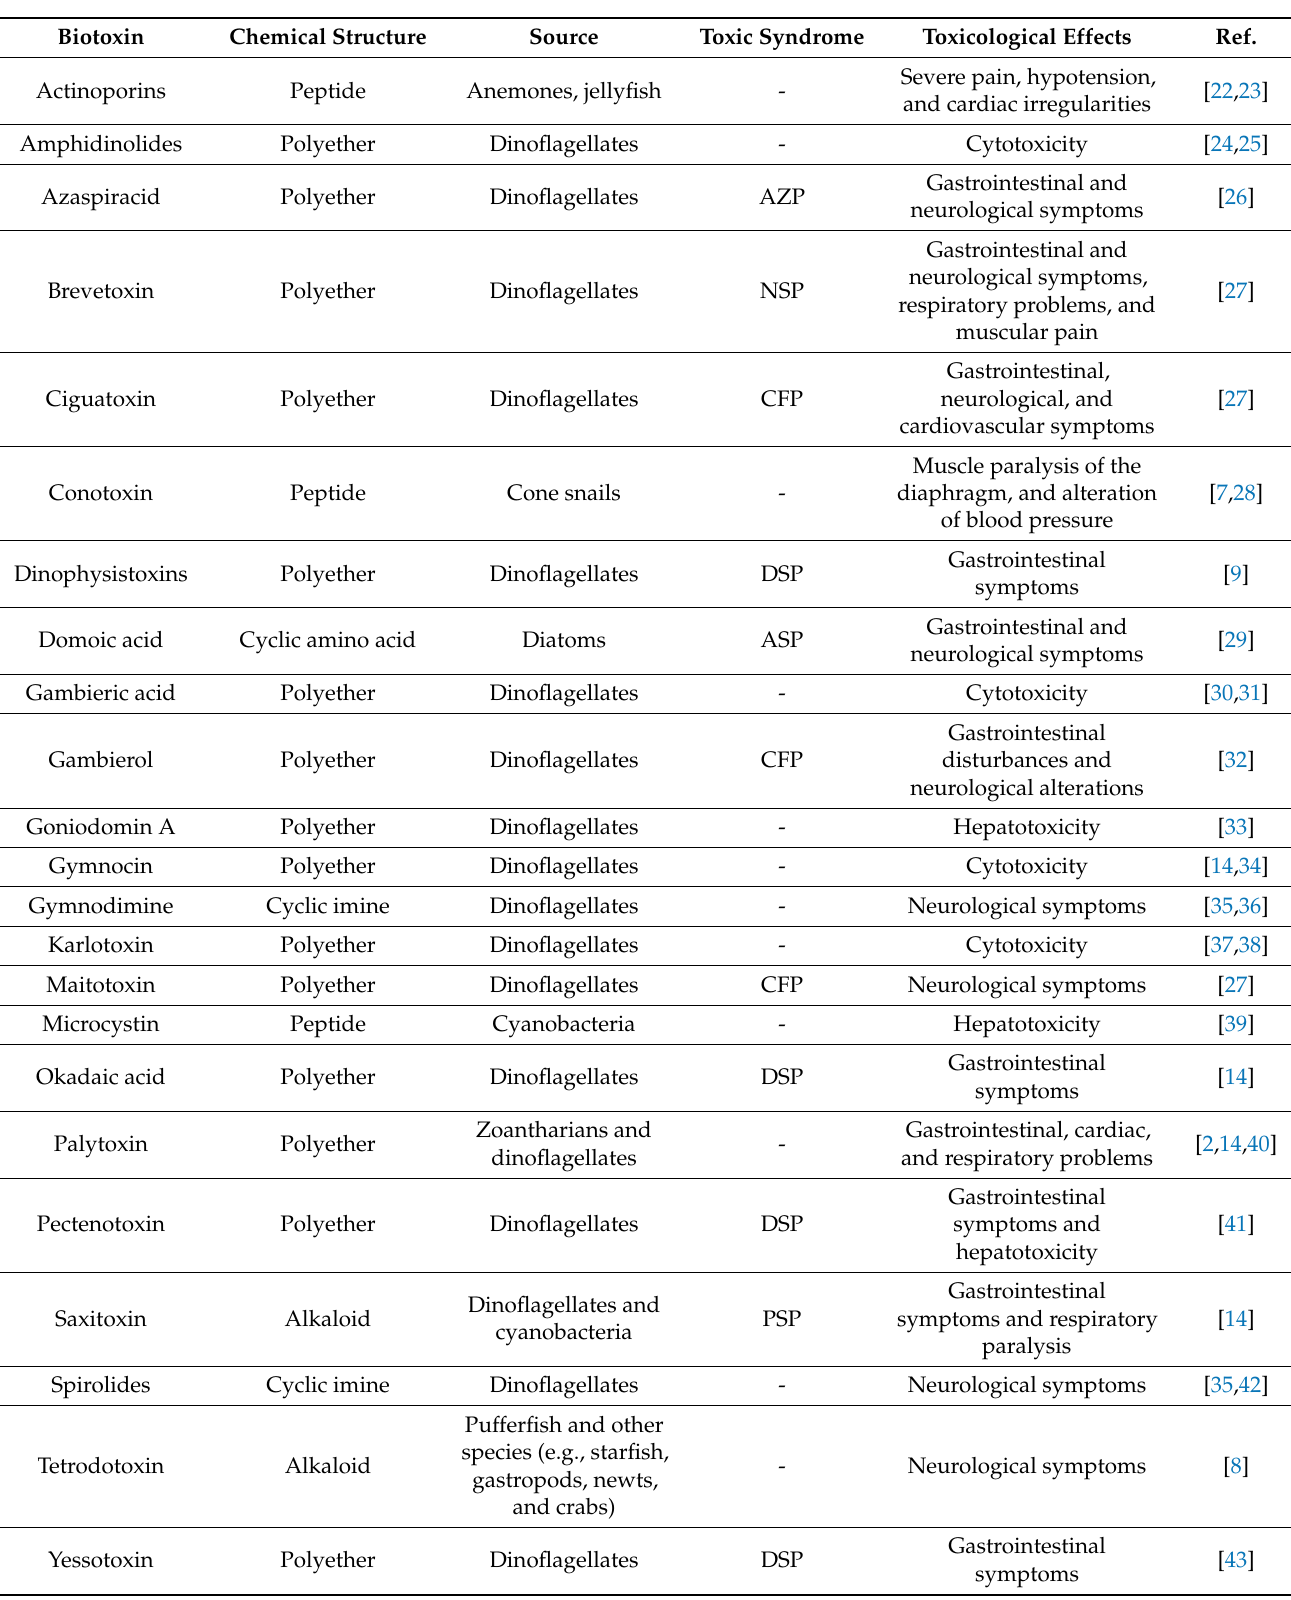
Table 1. Classification of common aquatic biotoxins, their toxicity, and frequently observed adverse symptoms in human